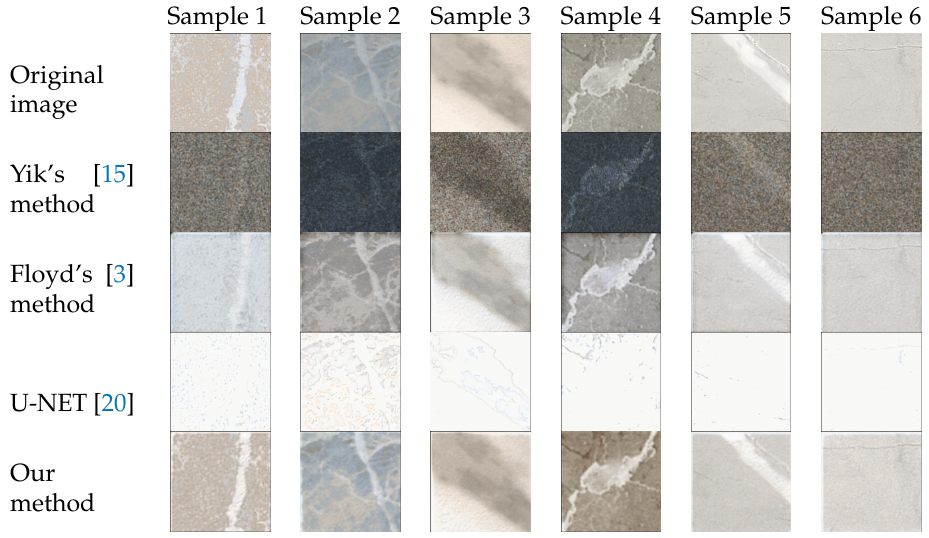
Figure 8. A comparison of the different methods.